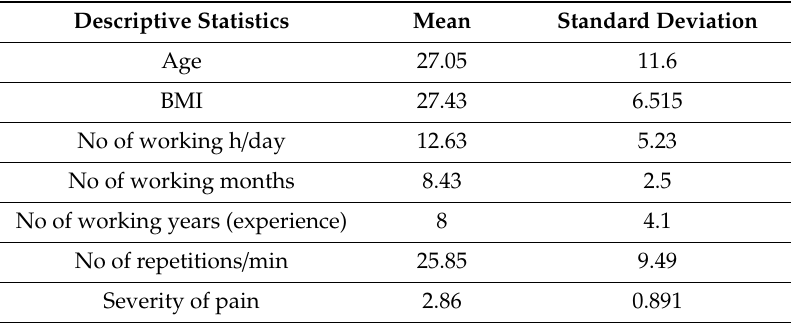
Table 2. Mean values of di ff erent personal and occupational